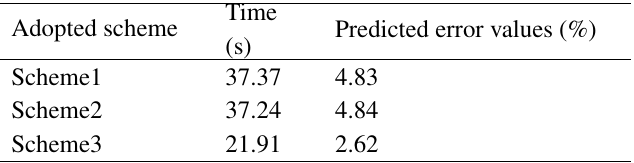
Fig. 16 The cumulative value of the importance of feature variables Table 4 Comparison of three